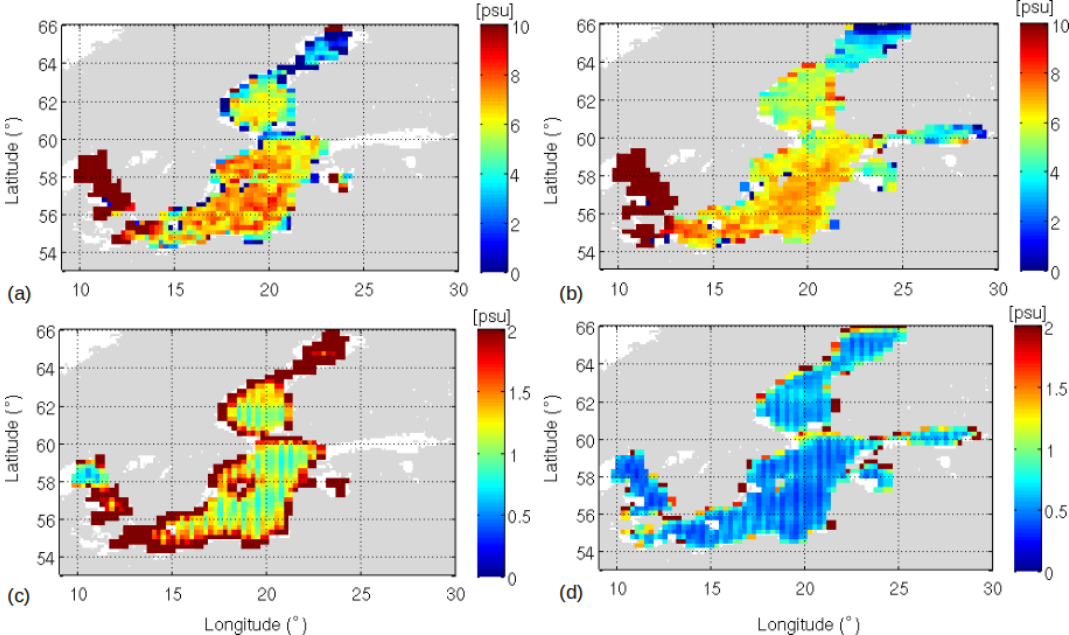
Figure 8. (a) 9d 0 . 25 ◦ L3 SSS map 15 to 23 January 2017, (b) 9d 0 . 25 ◦ L3 SSS map 15 to 23 July 2017, (c) error of SSS map in (a) , (d) error of SSS map in (b) .